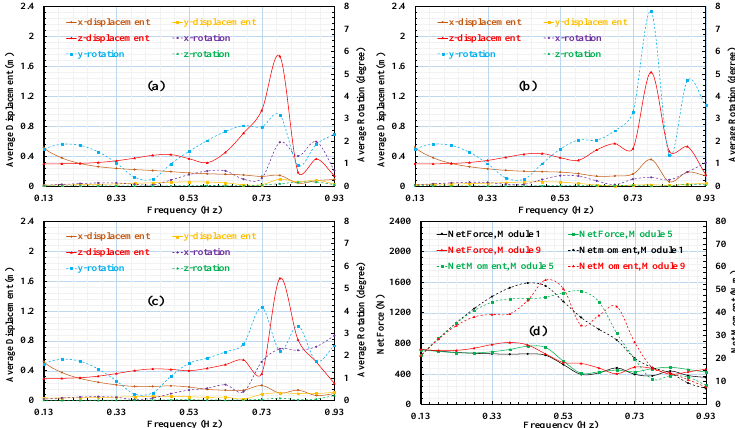
Figure 8. Average displacement of ( a ) module 1, ( b ) module 5, ( c ) module 9, and ( d ) net forces and moments corresponding to 0° of the wave direction .